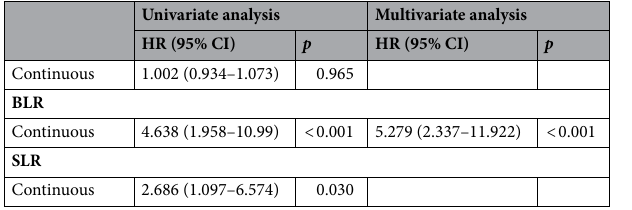
Table 2. Univariate and multivariate analyses associated with the overall survival (n = 411). HR hazard ratio, CI confidence interval, ASA American Society of Anesthesiology, BMI body mass index, CEA liver ratio, SLR spleen-to-liver ratio.